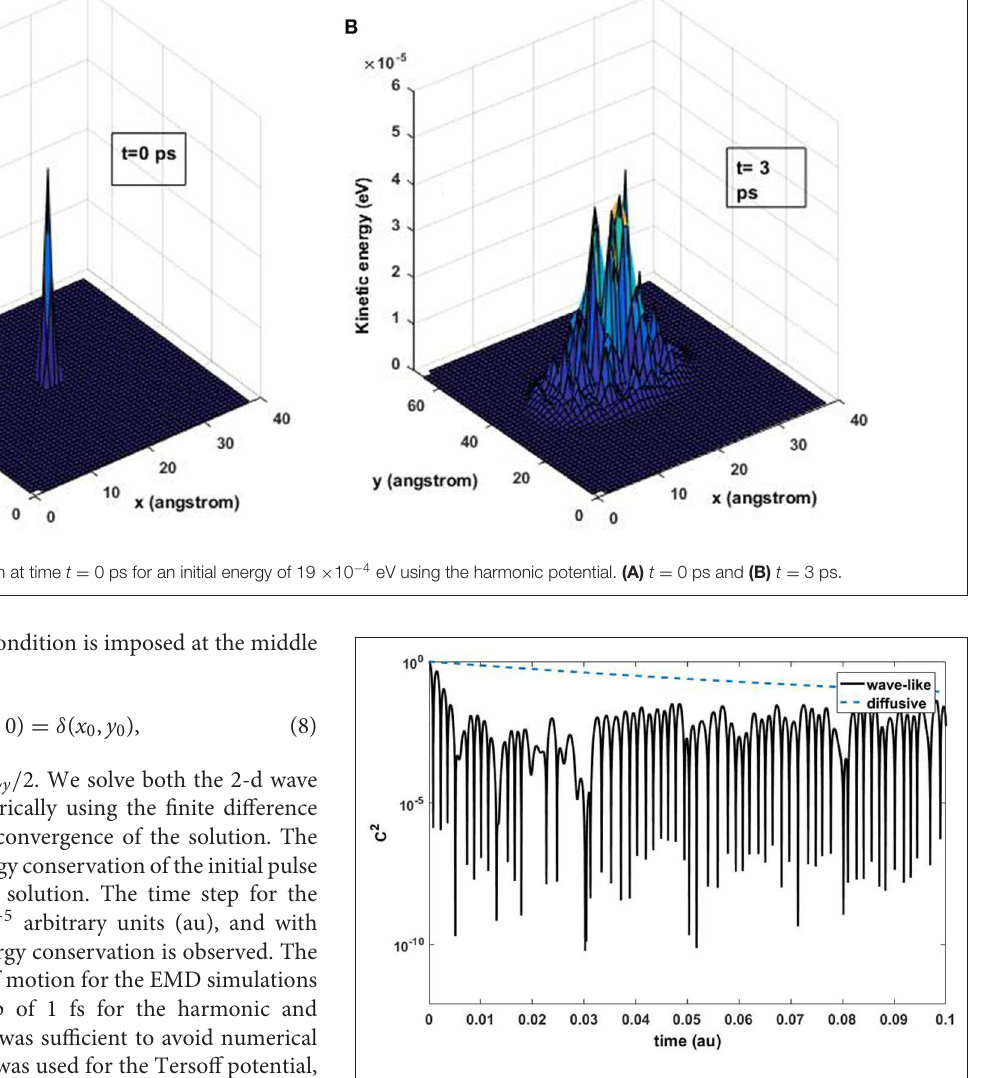
FIGURE 2 | Temporal evolution of the quantity C 2 ( x 0 , y 0 ) for the wave equation Equation (4) (solid line) and for the diffusion equation Equation (5) (dotted